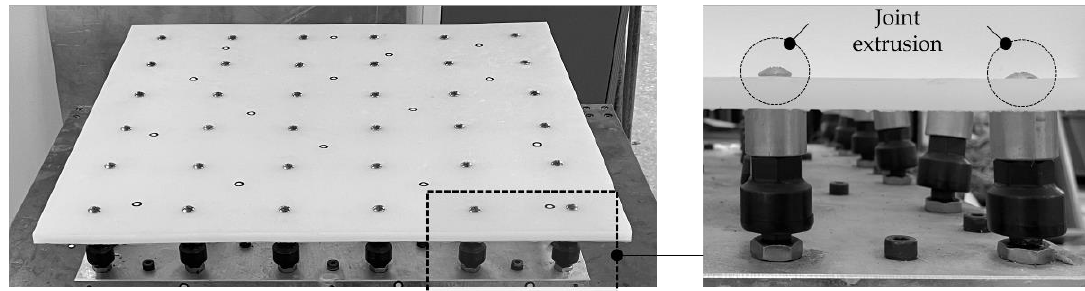
Figure 3. Surface of fixed-type molds.